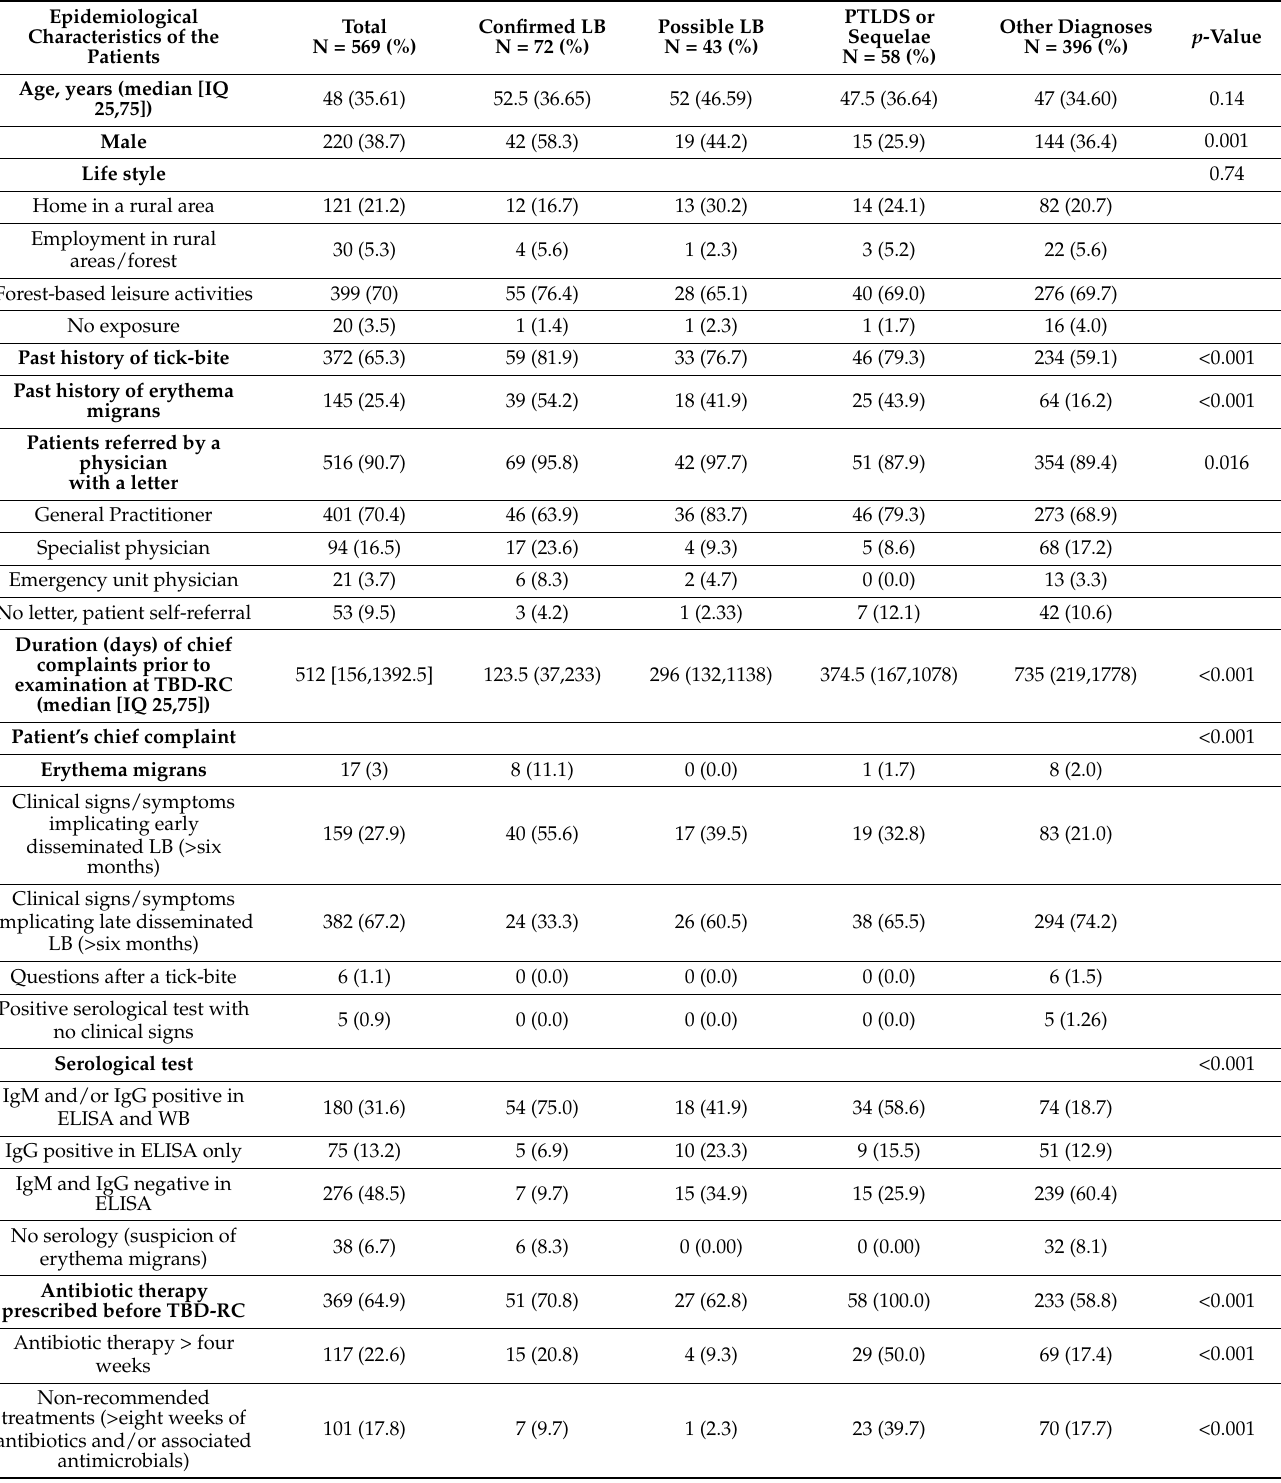
Table 3. Comparison of the epidemiological characteristics of the patients consulting the TBD-RC of Paris and Northern